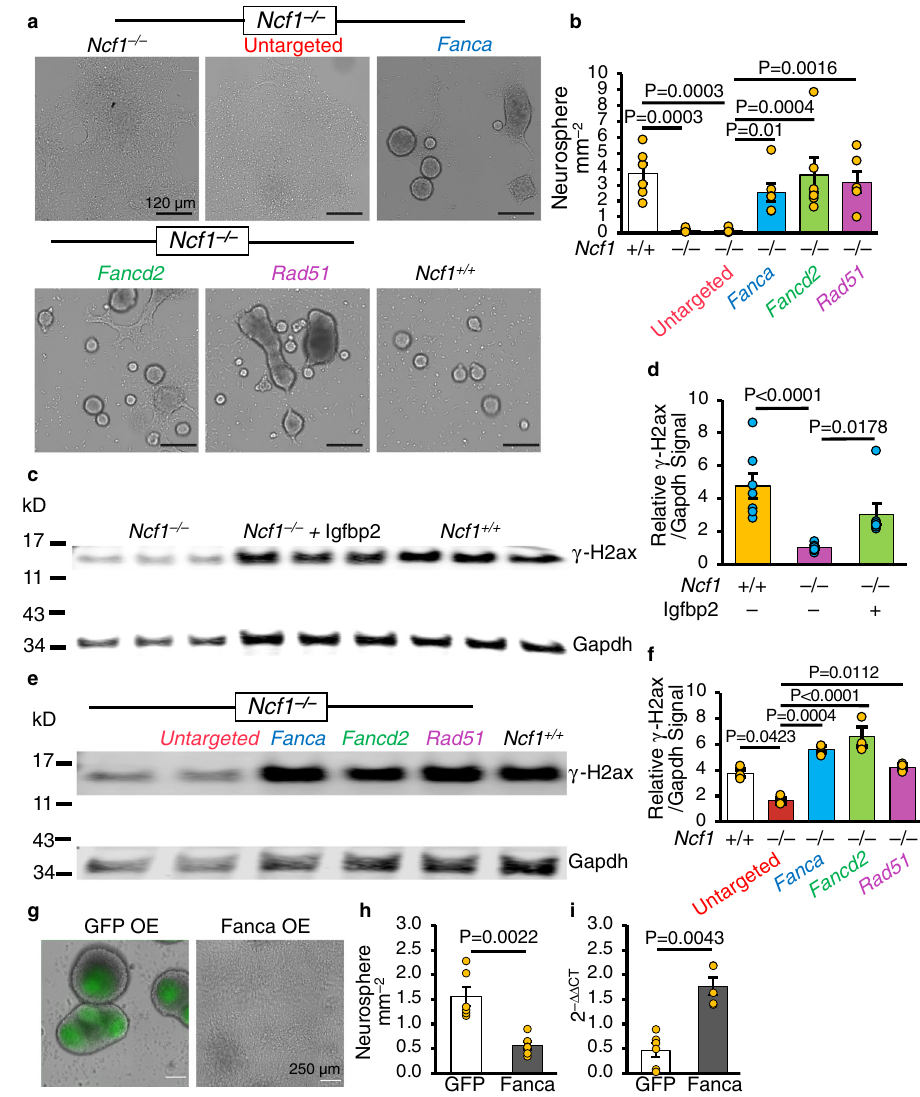
Fig. 4 | Ncf1/Igfbp2 axis promotes NSC lineage-commitment through repres- sion of NSC DNA repair pathways. a , b Photomicrographs ( a ) and quanti fi cation ( b ) of neurospheres ≥ 60 µ m in diameter 7 days after transfection of Ncf1 – / – NSCs with siRNA targeting Fanca, Fancd2 or Rad51 or negative control ( n =6 donors). c , d Westernblot analysis( c ) and quanti fi cation( d ) of γ -H2ax levels (normalized